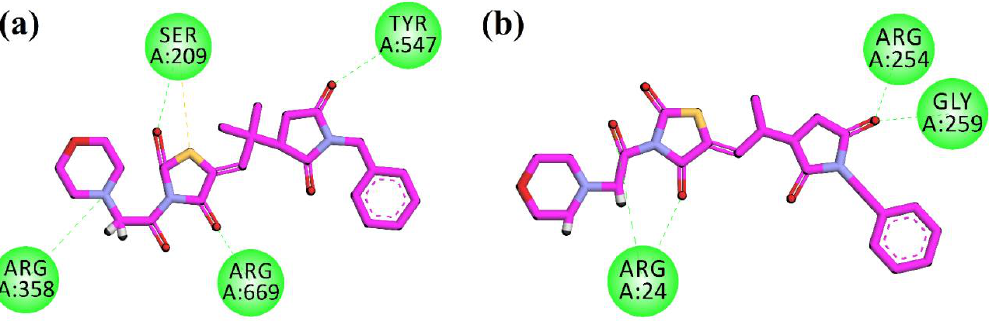
Figure 4. 2D interaction plots of 10d in the binding sites of DPP-4 (1X70) ( a ) and PTP-1B (1NNY) ( b